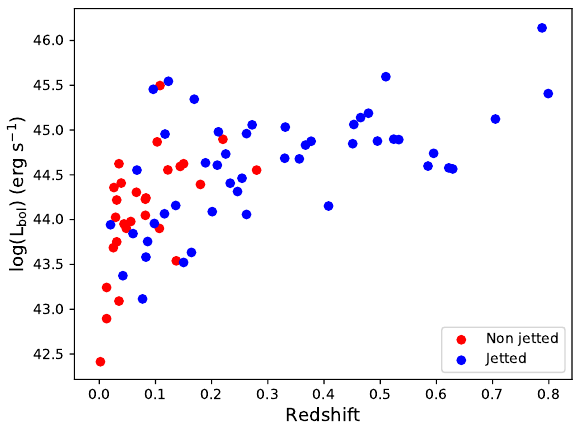
Figure 8. The bolometric luminosity of our sources as a function of their redshift. Non-jetted objects are shown in red, while jetted sources are plotted in